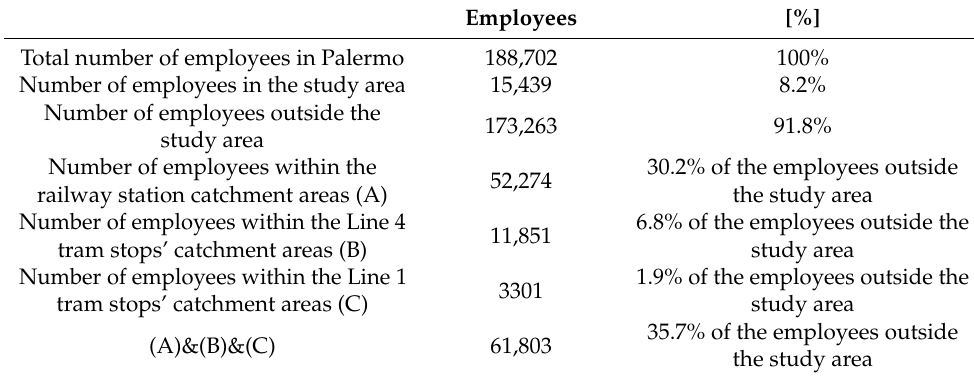
Table 3. Number of employees within the railway station catchment areas and the tram stops’ catchment